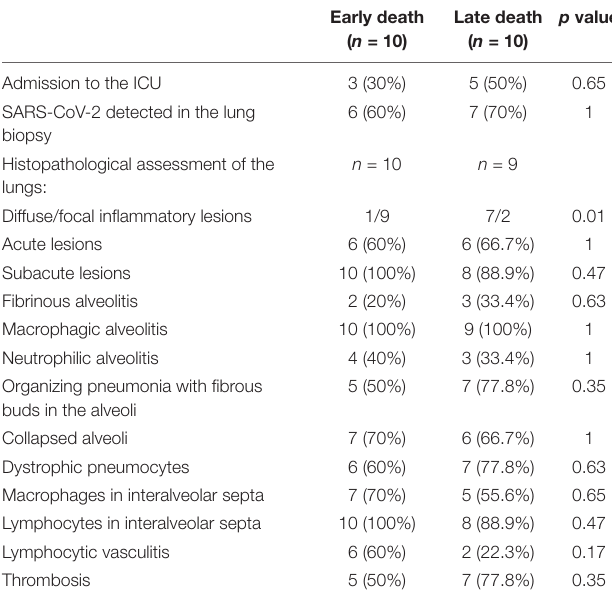
TABLE 4 | Pathology findings in the lung, by disease duration (early vs. late